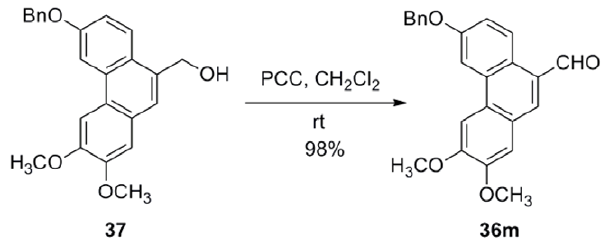
Figure 4. Synthesis of 6-benzyloxy-2,3-dimethoxyphenanth- ren-9-carboxaldehyde